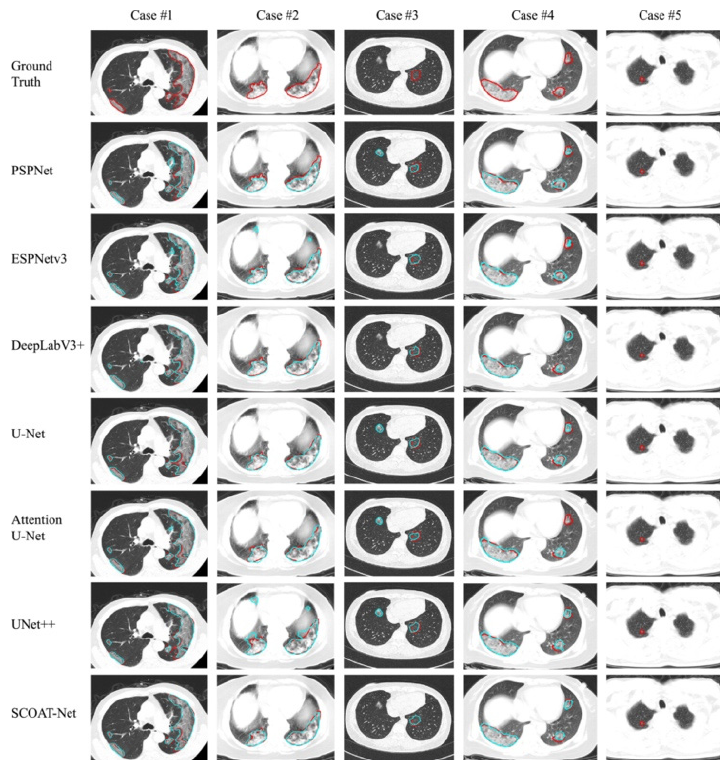
Figure 9. Segmentation performance of different models [74].